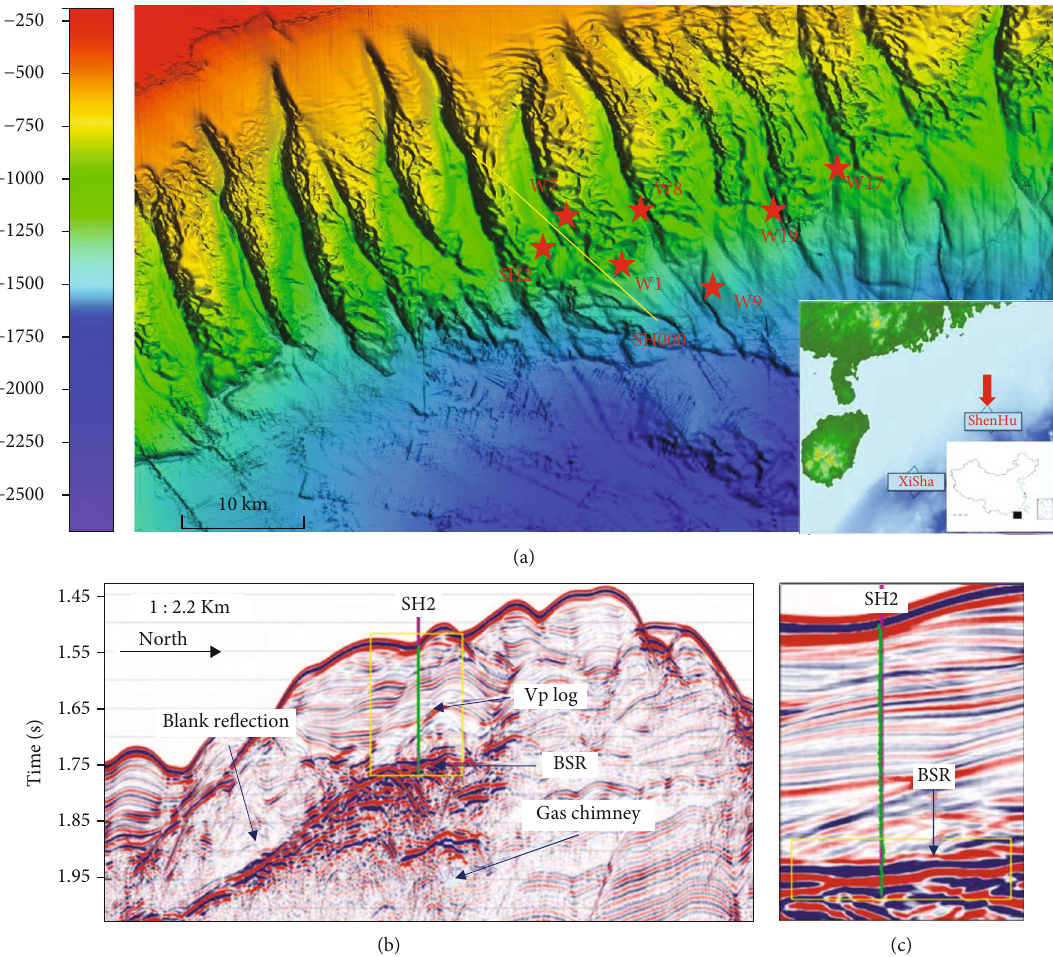
Figure 2: Study area in the Shenhu area [2]: (a) water depth and location of the study area; (b) seismic section SH000 in the work area; (c) zoom of the seismic section